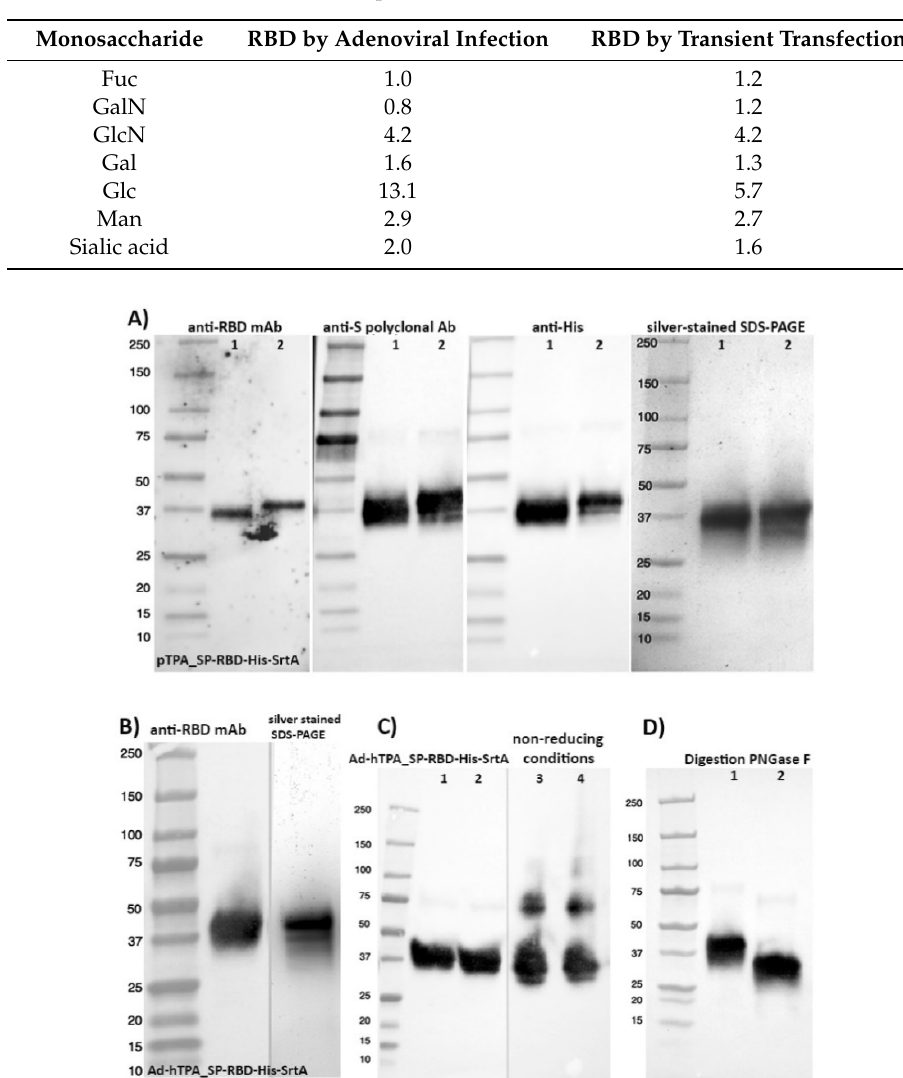
Figure 4. Characterization of final pools of purified RBD obtained in 3L-controlled bioreactor productions. or adenoviral infection. The analysis of RBD obtained by transient transfection ( A ) was performed with monoclonal and polyclonal antibodies against the Spike protein. Lane 1 in all panels shows reference RBD protein. ( B ) RBD from the adenoviral transfected culture. ( C ) Two different batches of RBD were expressed and purified as in ( B ) and were analyzed under reducing (lanes 1, 2) and non-reducing (lanes 3, 4) conditions by western blot using the polyclonal anti-S antibody. Under non-reducing conditions, the detection of high molecular weight structures over 75 and 110 kDa suggests the formation of multimeric structures. ( D ) Western blot, using the anti-S polyclonal antibody, of RBD obtained as in ( B ), before (lane 1) and after (lane 2) enzymatic deglycosylation with PNGase F.